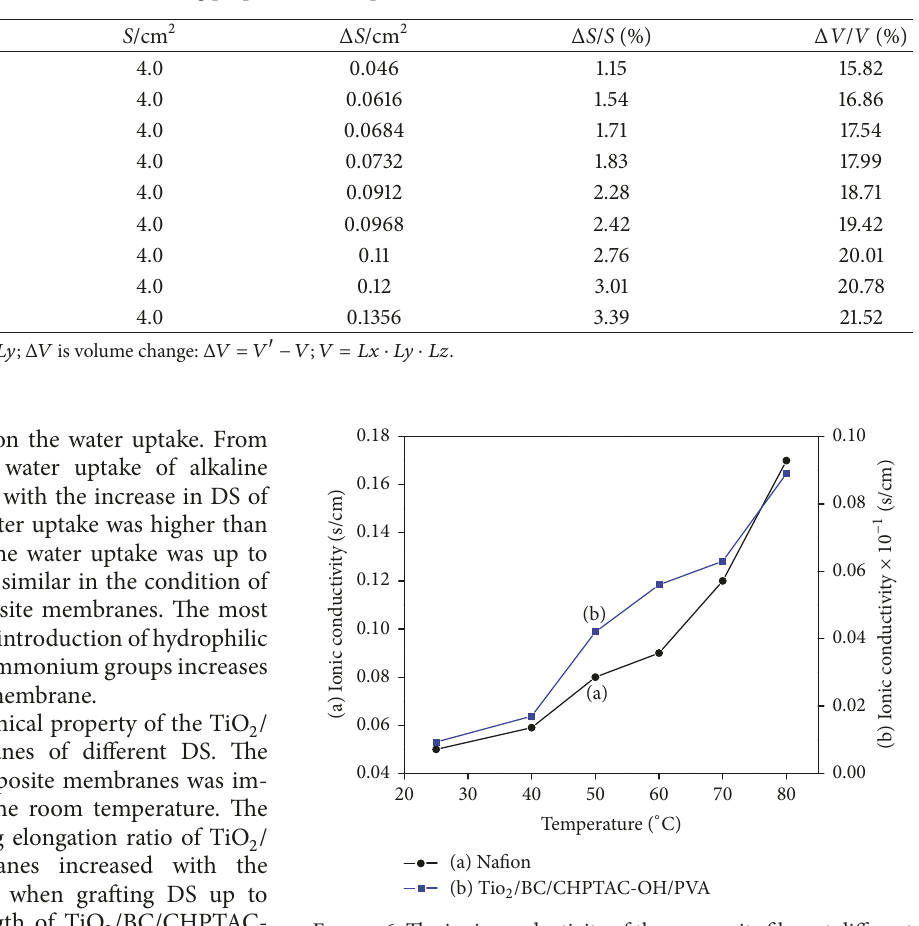
Table 2: Swelling properties of composite membrane.